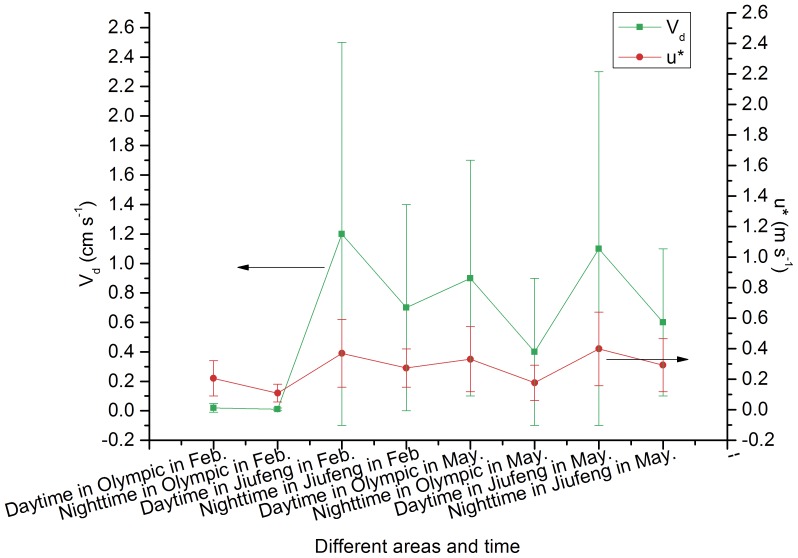
The relationship between u* and Vd.